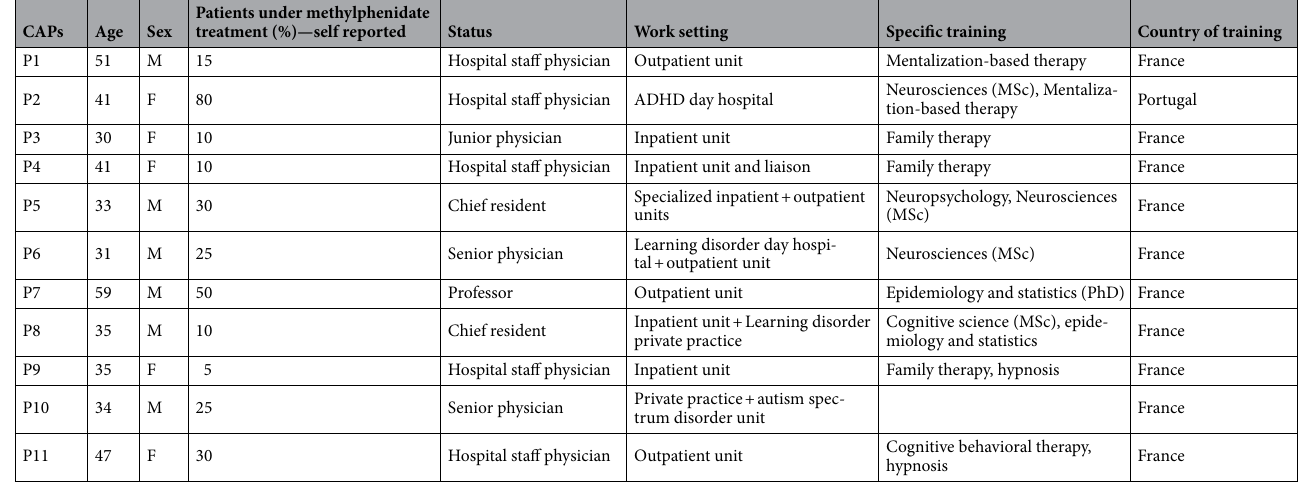
Table 4. CAPs’ characteristics.